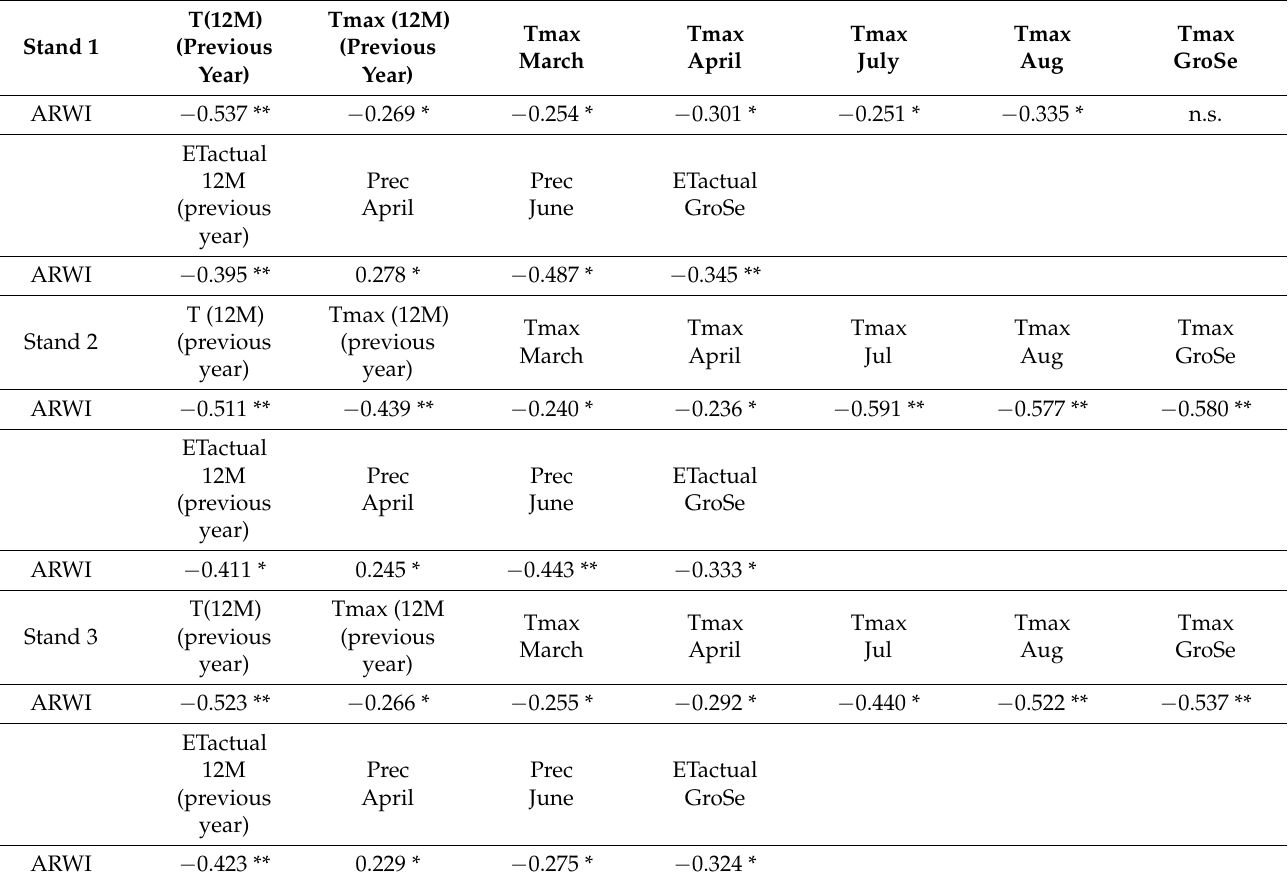
Table 2. Climate-ring width Pearson correlation (r) statistics 1 . Only the statisticallyimportant results are presented (* p < 0.05, ** p <